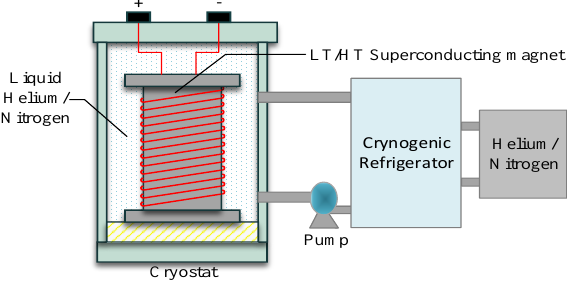
Figure 8. Superconducting magnetic energy storage (SMES)